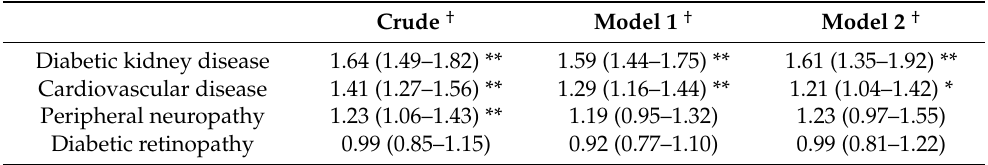
Table 4. Weighted odds ratios (95% confidence intervals) for chronic complications of people with diabetes with the increase per standard deviation uric